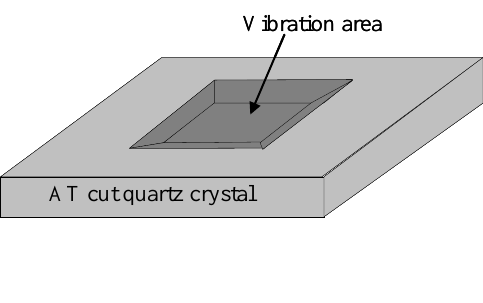
Figure 1. Schematic diagram of an inverted mesa structure for a high frequency